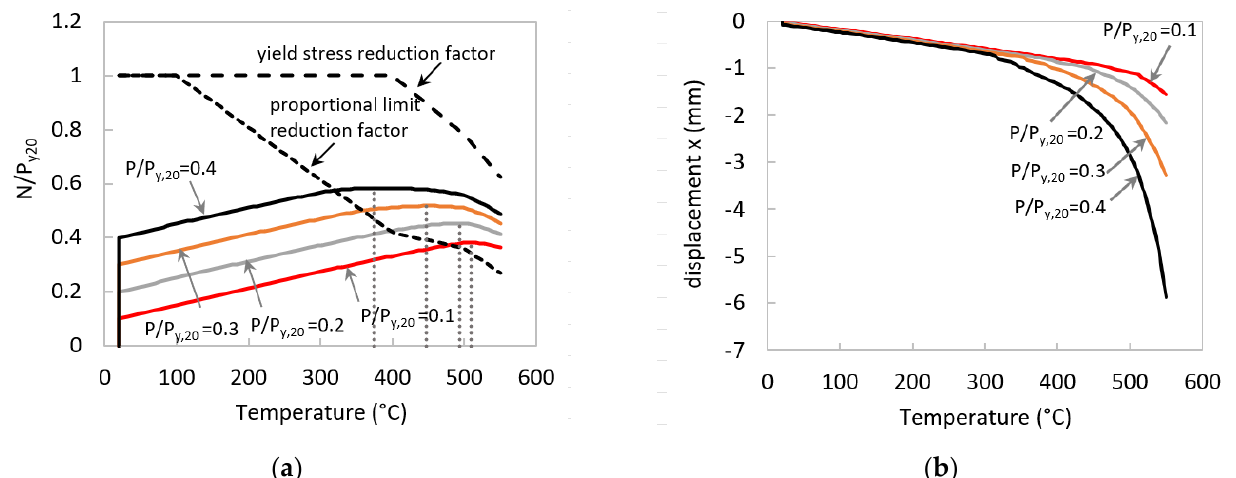
Figure 5. Behaviour of HEB300_550 °C columns during the fire stage. ( a ) Axial forces; ( b ) Global out-of-plane displacements ( x -axis) at mid-height of the column.